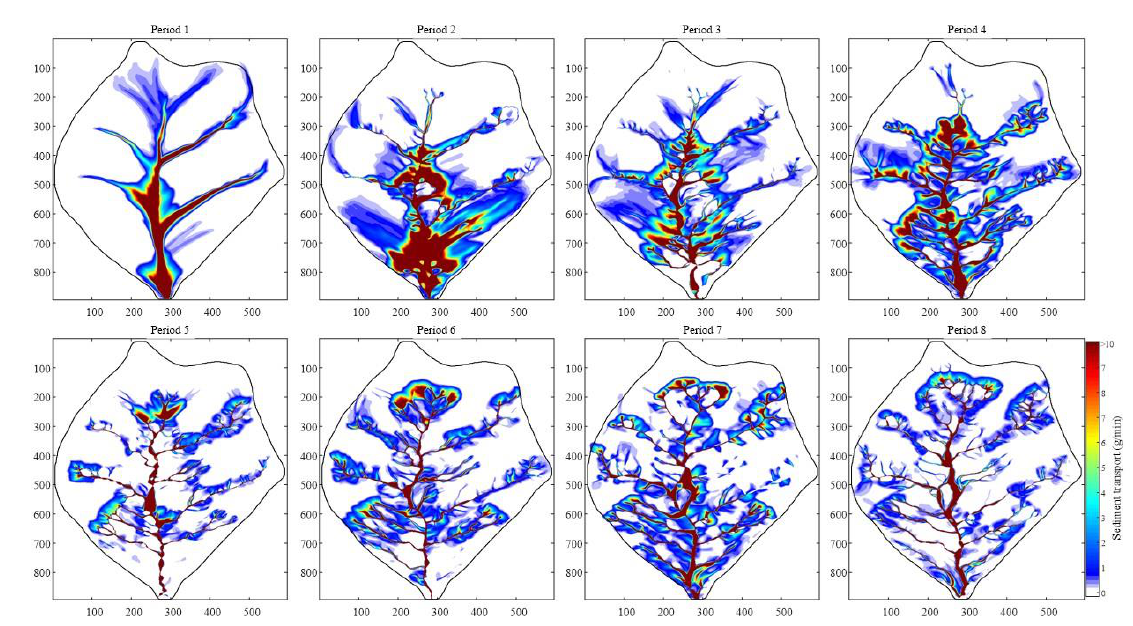
Figure 8 . 2-D sediment